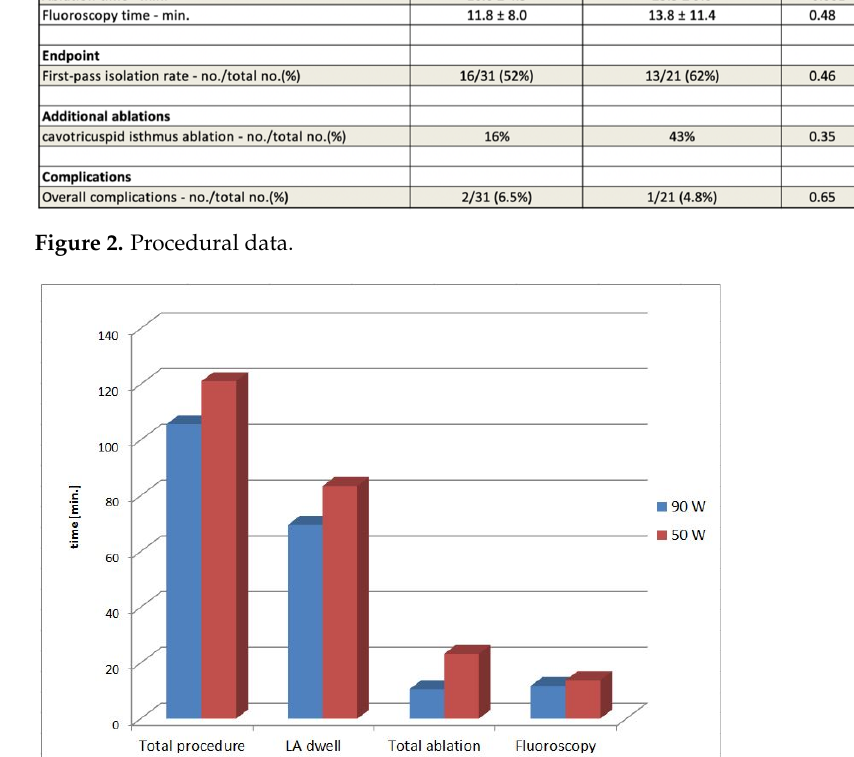
Figure 3. Comparison of procedural times between both ablation protocols.